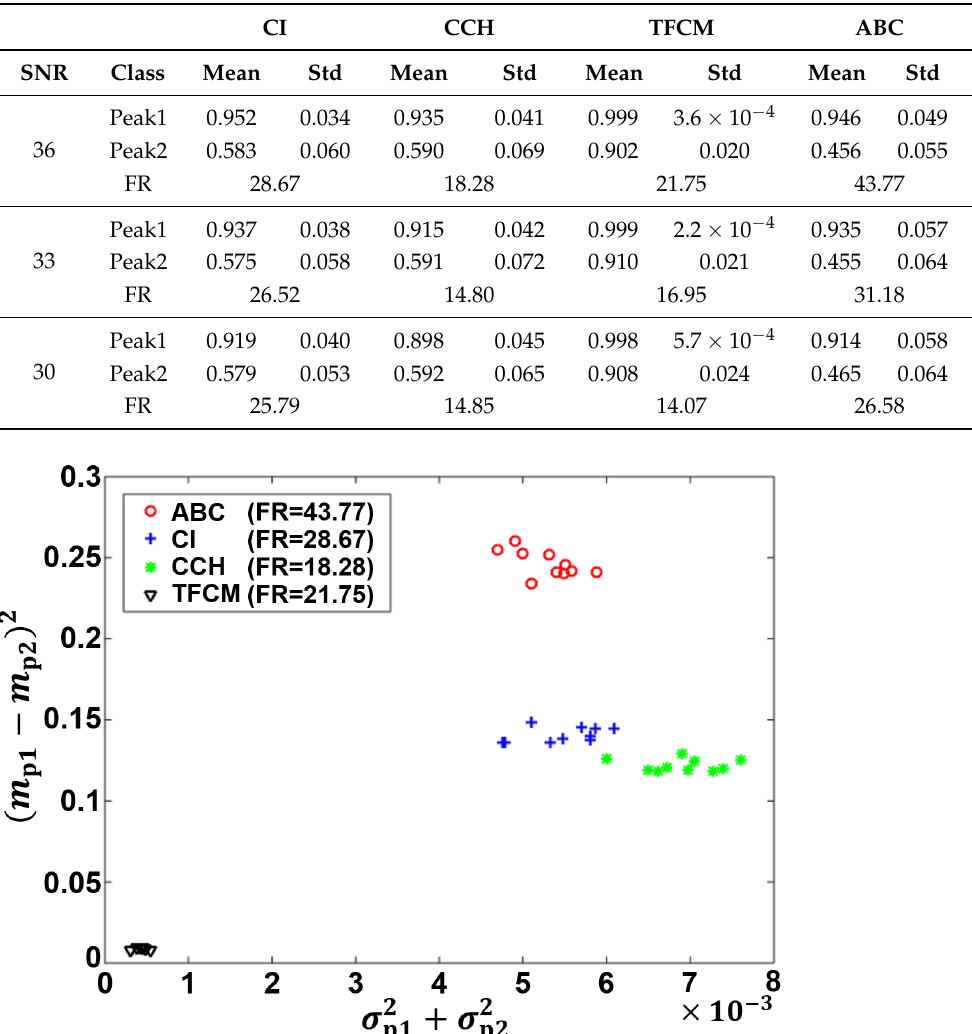
Table 5. Margins in CI, CCH, TFCM and ABC.